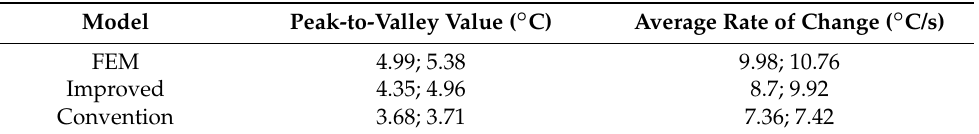
Table 4. Comparison of two